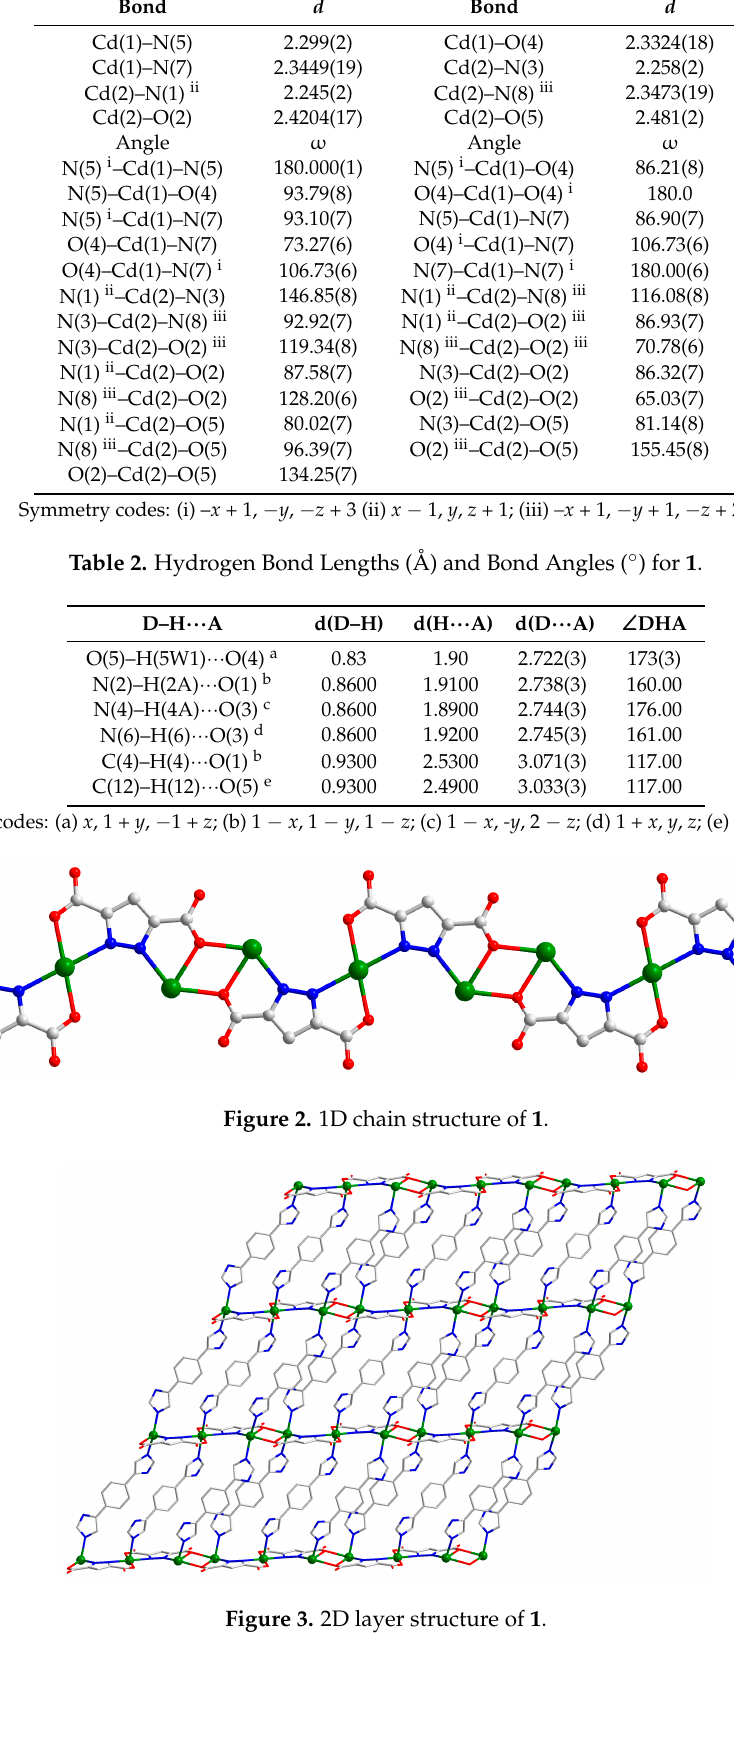
Figure 4. 3D supramolecular network structure of 1 linked by hydrogen bonding (pink dotted line) and π ··· π stacking interactions by a centroid − centroid distance of 3.86 Å (blue dotted line). Table 1 Selected bond lengths (Å) and bond angles ( ° ) for 1 Bond